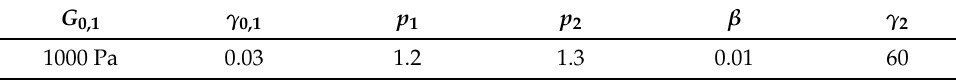
Table 4. Values of parameters estimated through rough fitting.